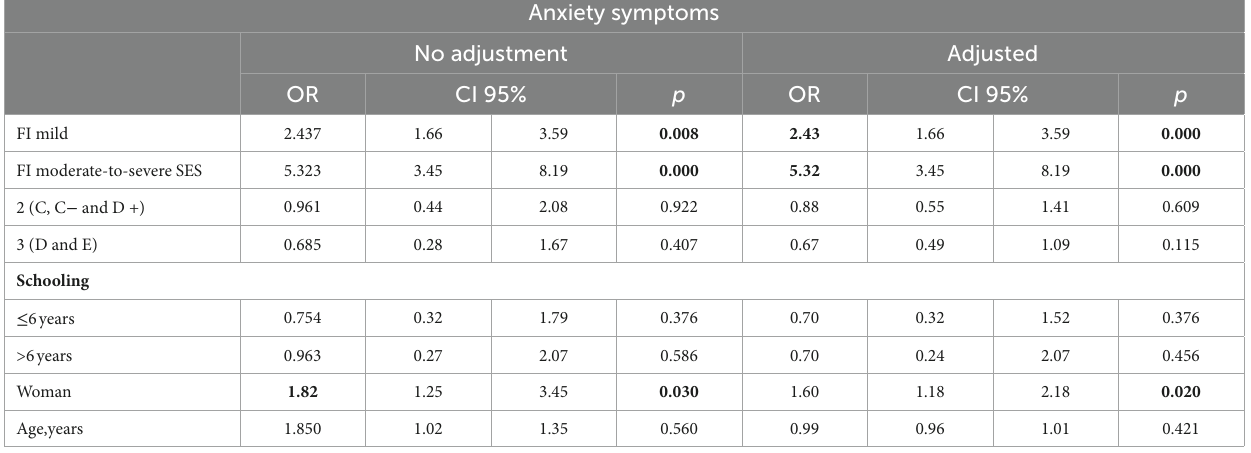
TABLE 4 Logistic regression on the association between food insecurity and anxiety symptoms.